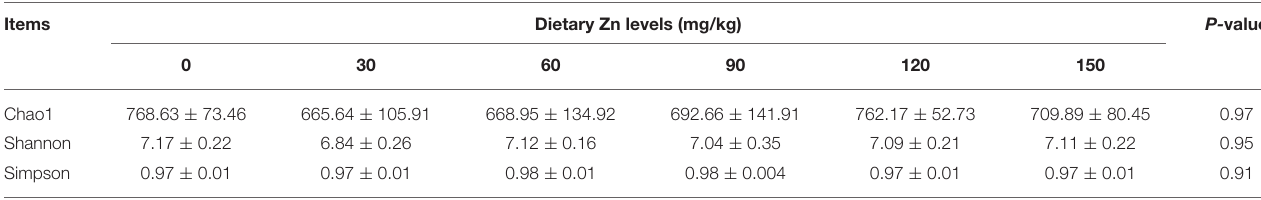
TABLE 8 | Effect of dietary Zn-Met on the diversity of cecal digesta microbiota in ducks. Items Dietary Zn levels (mg/kg)